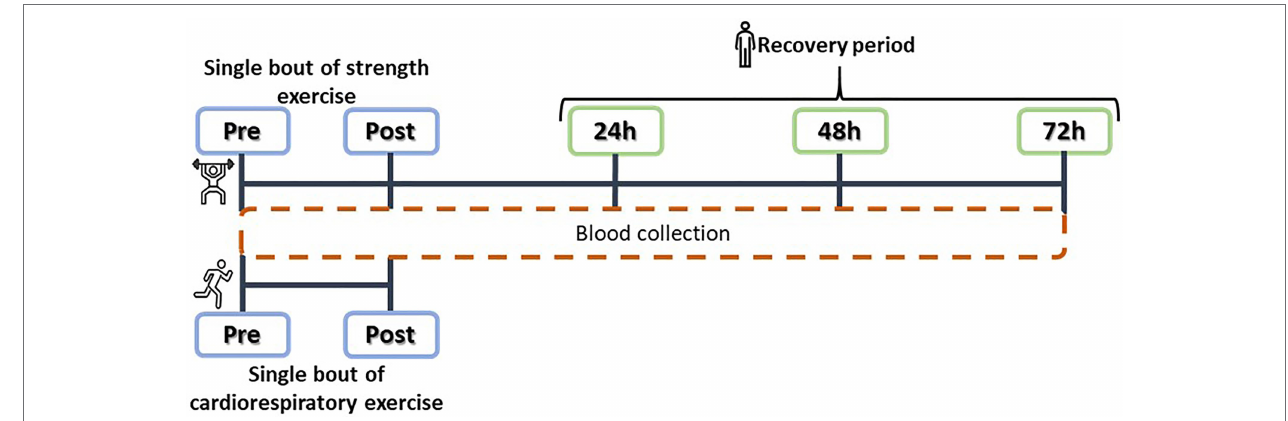
FIGURE 2 | Experimental design: acute cardiorespiratory (CR) and strength training (ST) interventions, and plasma S α KI